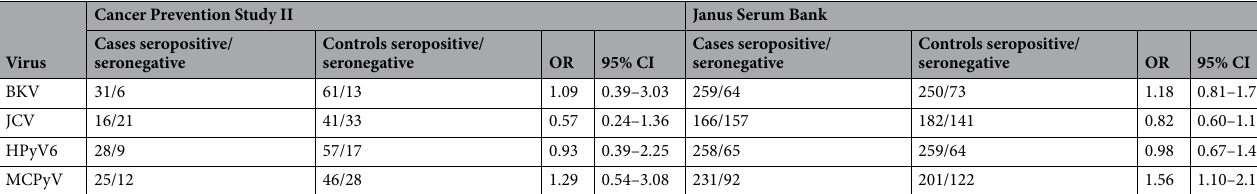
Table 2. Association of polyomavirus seroprevalence with glioma risk in the Cancer Prevention Study II and Janus Serum Bank. Analyses based on 37 glioma cases (27 GBMs) and 74 matched controls for CPS-II and 323 glioma cases (196 GBMs and 127 nonGBMs) and 323 matched controls in Janus Serum Bank. Referent group in all analyses comprised of seronegative (median fluorescence intensity < 250) individuals. ORs and CIs were conditioned on the following matching factors: birth date within 1 year, sex, and date of blood draw within 6 months for CPSII; and age within 2 years, sex, county of residence, and date of blood collection within 12 months for Janus. BKV BK virus, JCV JC virus, HpyV6 Human Polyomavirus 6, MCPyV Merkel Cell Polyomavirus, GBM glioblastoma, OR odds ratio, CI confidence interval.